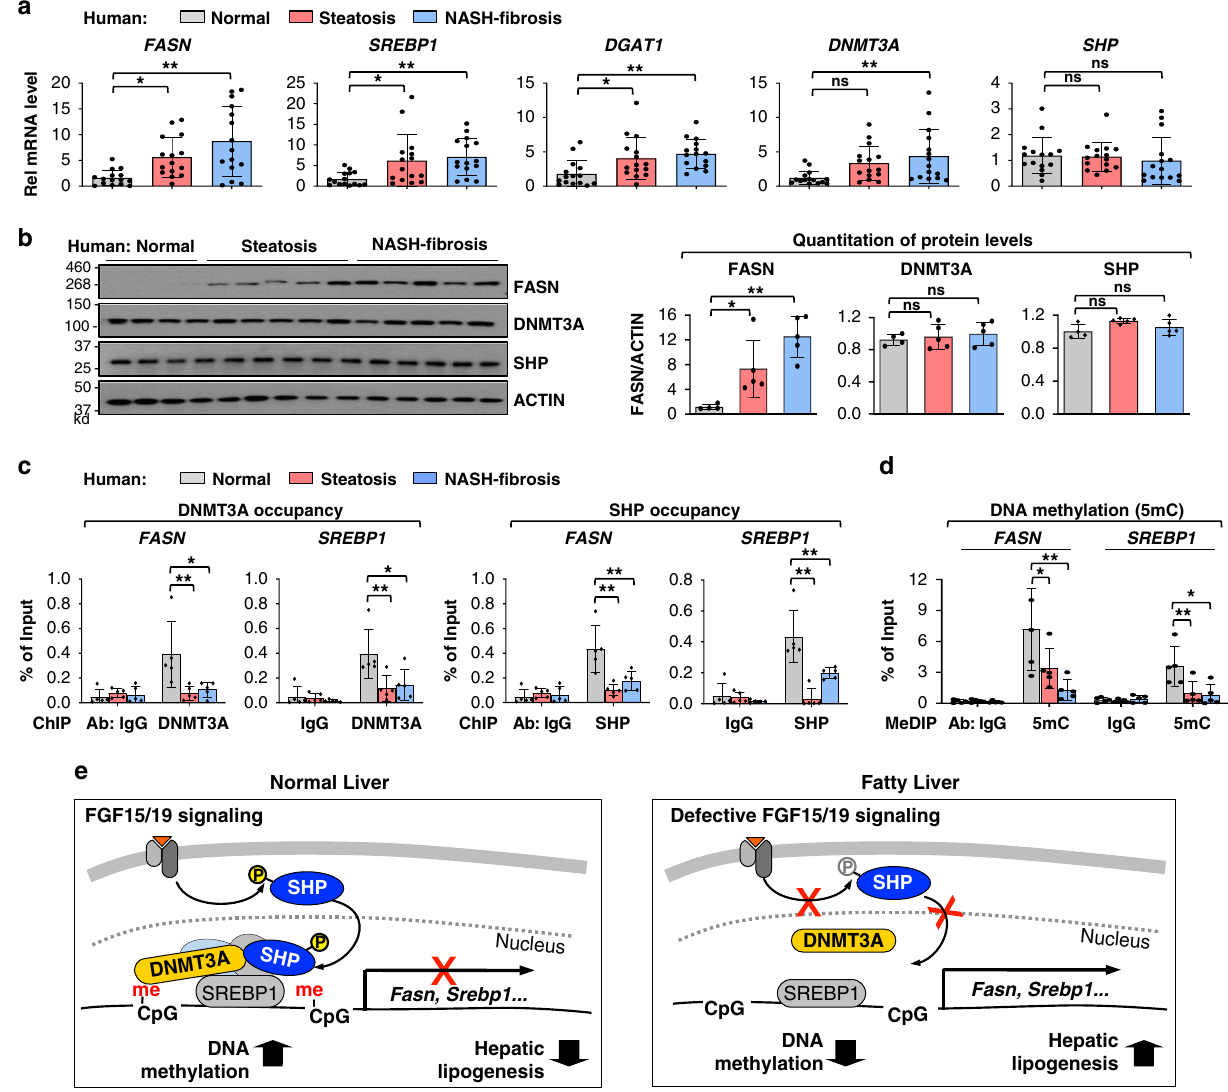
Fig. 9 In NAFLD patients, occupancy of DNMT3A and SHP and DNA methylation at lipogenic genes are decreased, which is consistent with increased gene expression. a Hepatic mRNA levels of the lipogenic genes, DNMT3A and SHP , determined by RT-qPCR for 15 normal individuals and 15 simple steatosis and 15 severe NASH- fi brosis patients. b Protein levels of FASN, DNMT3A, and SHP in liver extracts of normal subjects and NAFLD patients. Liver extracts from 15 individuals were randomly combined to form 4 (normal, 3 or 4 individuals) or 5 (steatosis and NASH, 3 individuals) pooled samples. c Liver extracts from 15 individuals were randomly combined to form 5 pooled samples, each containing 3 individual samples. DNMT3A and SHP occupancies at the FASN and SREBP1 promoters. d Methylated DNA at the FASN and SREBP1 promoters. a – d The mean and standard deviation are plotted. a ( n = 15 individuals), b ( n = 4, normal, n = 5, patients), c , d (n = 5, individuals). Statistical signi fi cance was determined by ( a , b ) one-way ANOVA or ( c , d ) two-way ANOVA with the Tukey post-test. * P < 0.05, ** P < 0.01, ns, statistically not signi fi cant. e Model: An FGF15/19-SHP-DNMT3A axis represses hepatic lipogenesis physiologically but may be defective in fatty liver. Normal liver (left): FGF15/19 signaling-activated SHP via phosphorylation recruits DNMT3A to SREBP1-bound lipogenic genes, which results in DNA methylation and epigenetic repression of lipogenic genes in the late fed state. Fatty liver (right): In NAFLD patients and obese mice, impaired FGF15/19 signaling leads to decreased phosphorylation of SHP, resulting in decreased nuclear localization and occupancy of SHP at lipogenic genes, and consequently, decreased recruitment of DNMT3A and DNA methylation, which is associated with increased gene hepatic steatosis 50 . SHP-KO mice are lean but display insulin resistance 51 , and Shp deletion in the liver was also shown to prevent hepatic steatosis in mice fed a western diet 52 . In contrast, bile acid-activated FXR reduces hepatic TG levels by inhibiting SREBP1 via SHP 53 and that viral-mediated overexpression of SHP in obese mice decreases hepatic TG levels in part by reg-